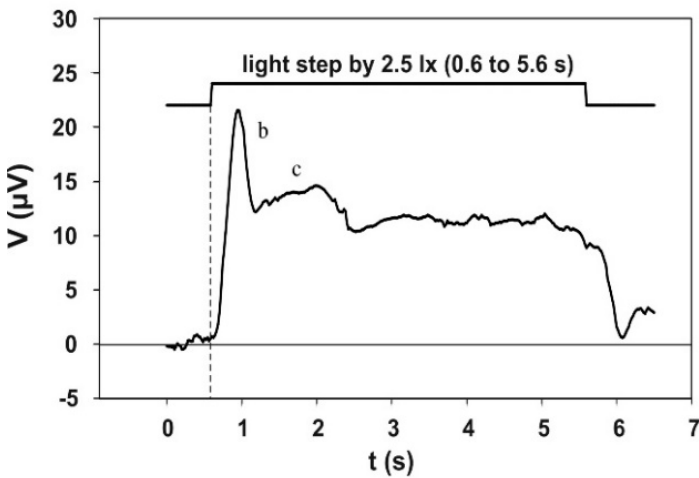
Figure 6. Electroretinographic response to the 5 s adaptation pulse (test subject 9, average course of 130 individual responses). The b- and the c-wave are clearly visible. The peak of the b-wave is located at about 0.3 s after the beginning of the adaptation